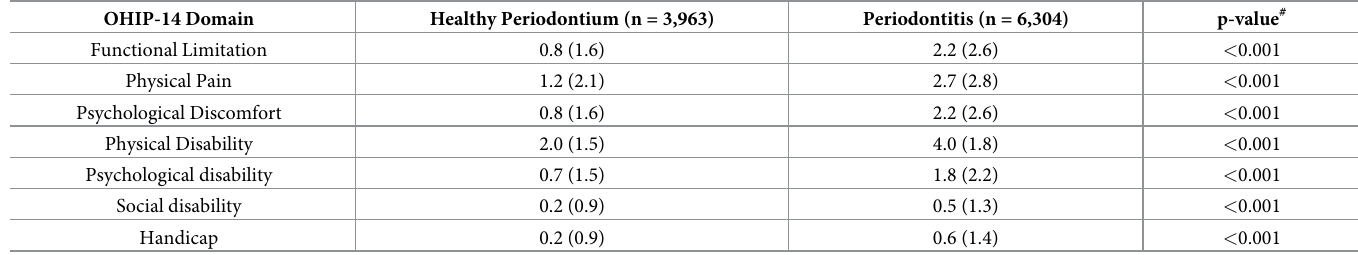
Table 2. OHIP-14 domains according to the periodontal status (healthy vs. periodontitis) assessed through panoramic radiograph for all patients (n = 10,267).